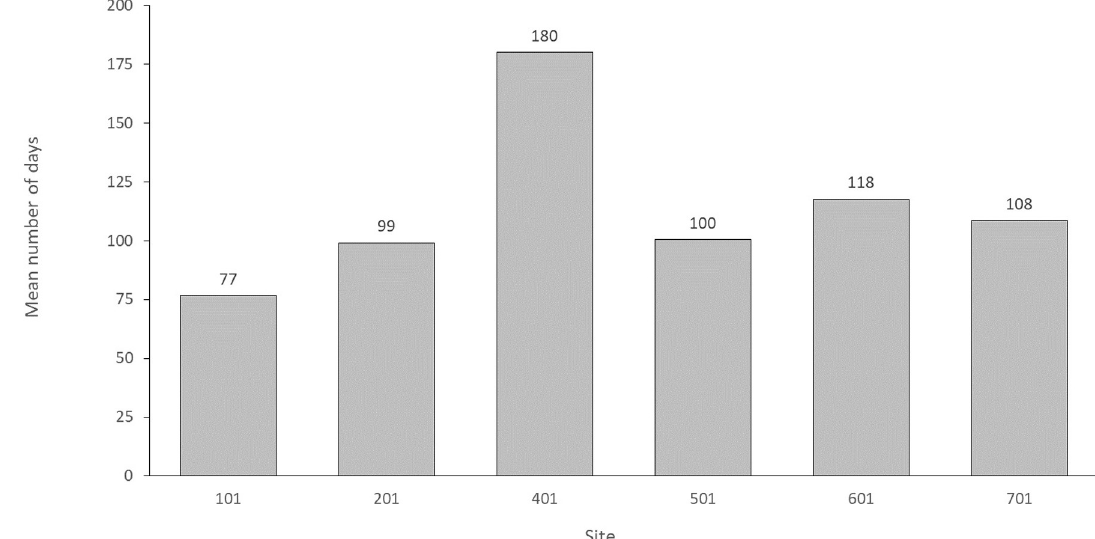
Fig 4. Mean duration of catheter use, per patient, by